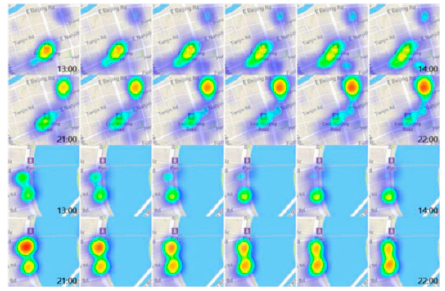
Figure 14. Morphing results of pedestrian flow visualization between two time steps [45].